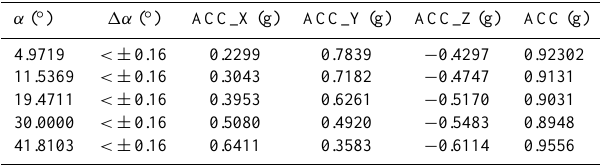
Table 8. Tilt angles around + X ( α tilt angle) and experimental val- ues (converted into g) for the first five steps.